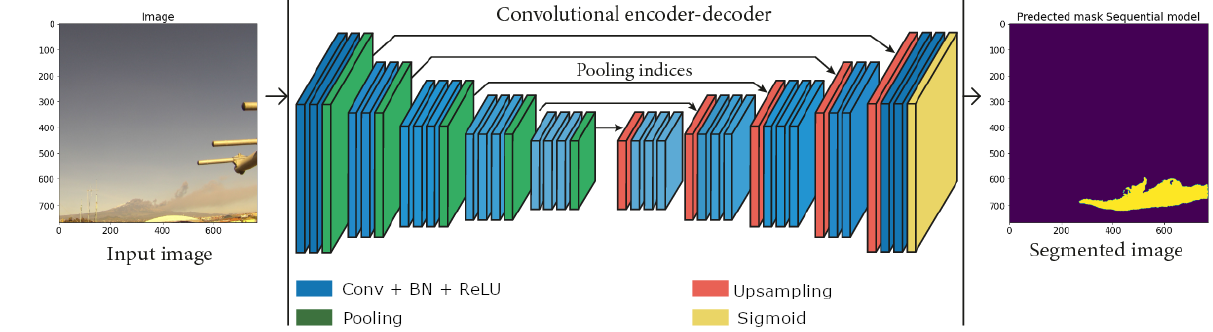
Figure 7. SegNet architecture.